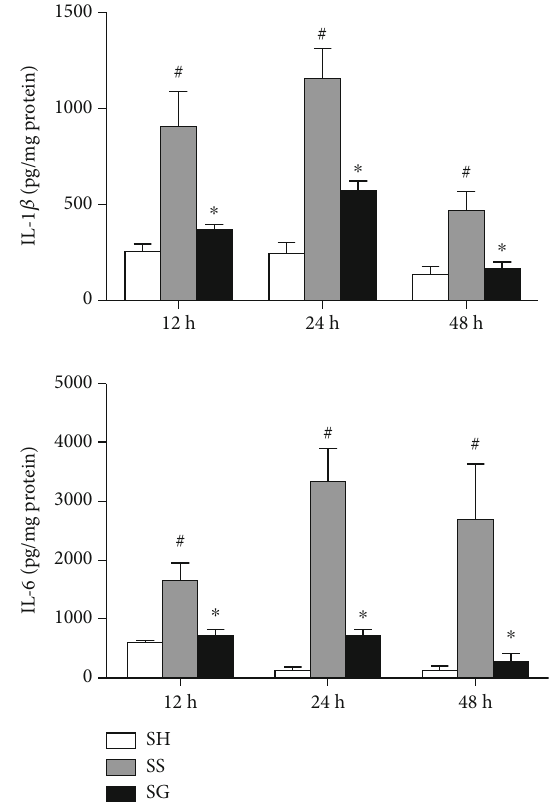
Figure 4: Concentrations of the in fl ammatory cytokines, interleukin (IL)-1 β , and IL-6, in the peritoneal lavage fl uid. SH: sham-operated group; SS: sepsis group with saline; SG: sepsis group with glutamine. Values are expressed as the mean ± SEM . All data are representative of duplicate measurements at 12, 24, and 48h after cecal ligation and puncture (CLP) ( n = 8for each group ). Di ff erences among groups at each time point were analyzed by a one-way ANOVA followed by Tukey ’ s post-hoc test. The symbol “ # ” signi fi cantly di ff ers from the SH group; the symbol “ ∗ ” signi fi cantly di ff ers from the SS group ( p < 0 : 05